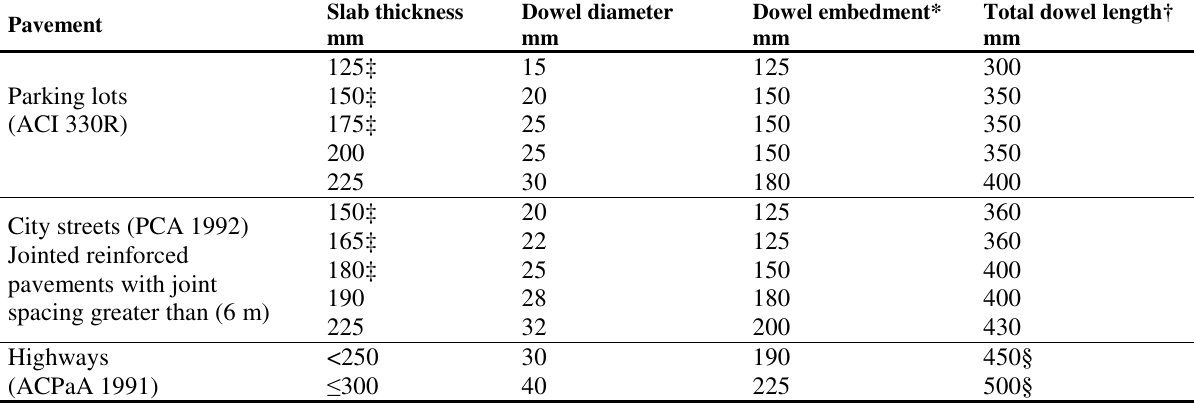
Dowels for Concrete Parking Lots, City Streets and Highways